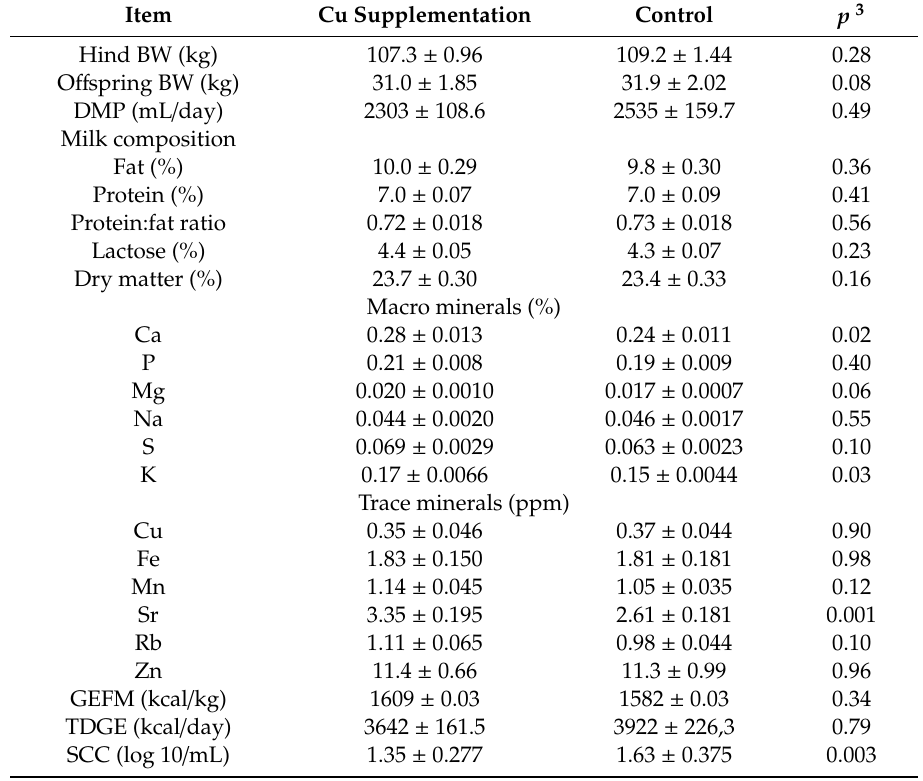
Table 2. E ff ects of parenteral Cu supplementation 1 of late-gestating and lactating Iberian red deer hinds fed a balanced diet on body weight (BW) of hind and o ff spring throughout lactation, daily